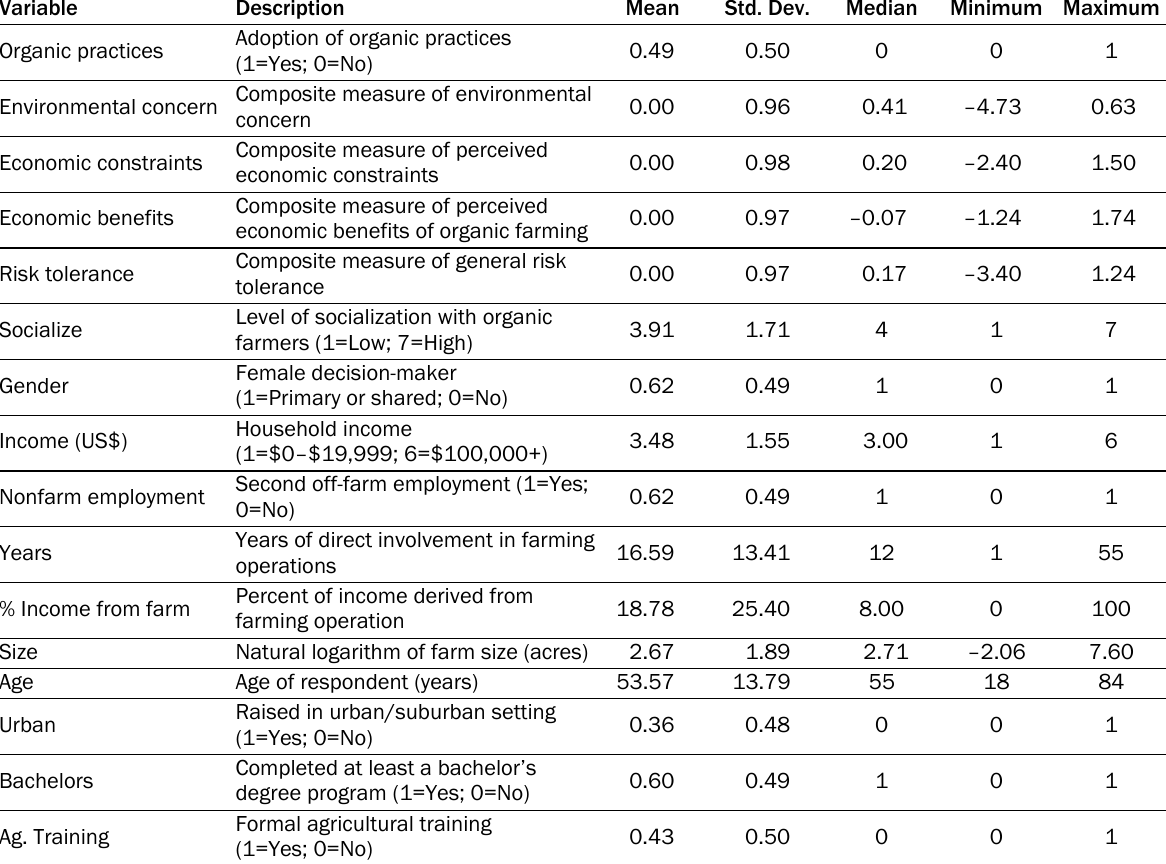
Table 1. Description and Summary Statistics of Parameters Included in Logistic Regression